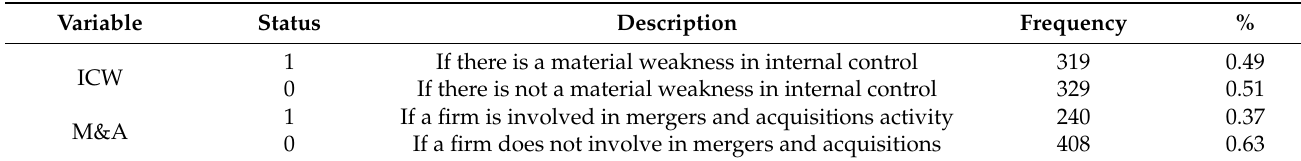
Table 4. Descriptive statistics of qualitative